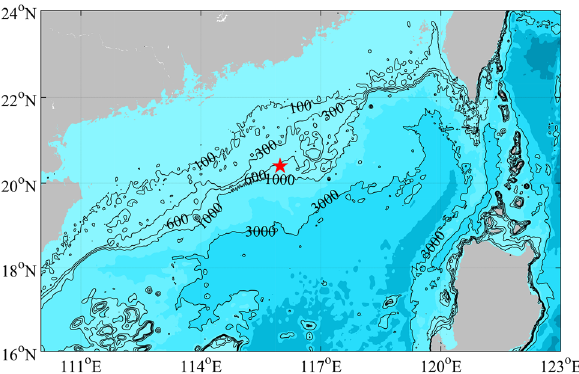
Figure 1. Map of the mooring near the Dongsha Islands in the SCS. The red pentagram denotes the mooring station. The solid lines and shadow denote the water depth. Figures are plotted using MATLAB R2016b (http:// www. mathw orks.